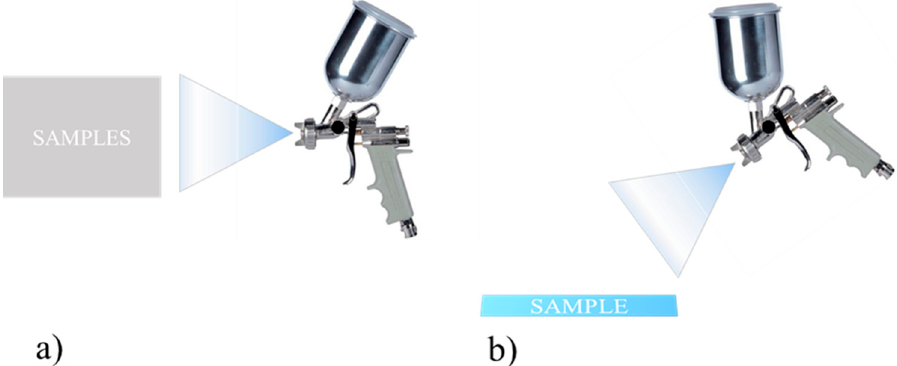
Figure 4. Schematic drawing of deposition process according to ( a ) Procedure 1 and ( b ) Procedure 2.